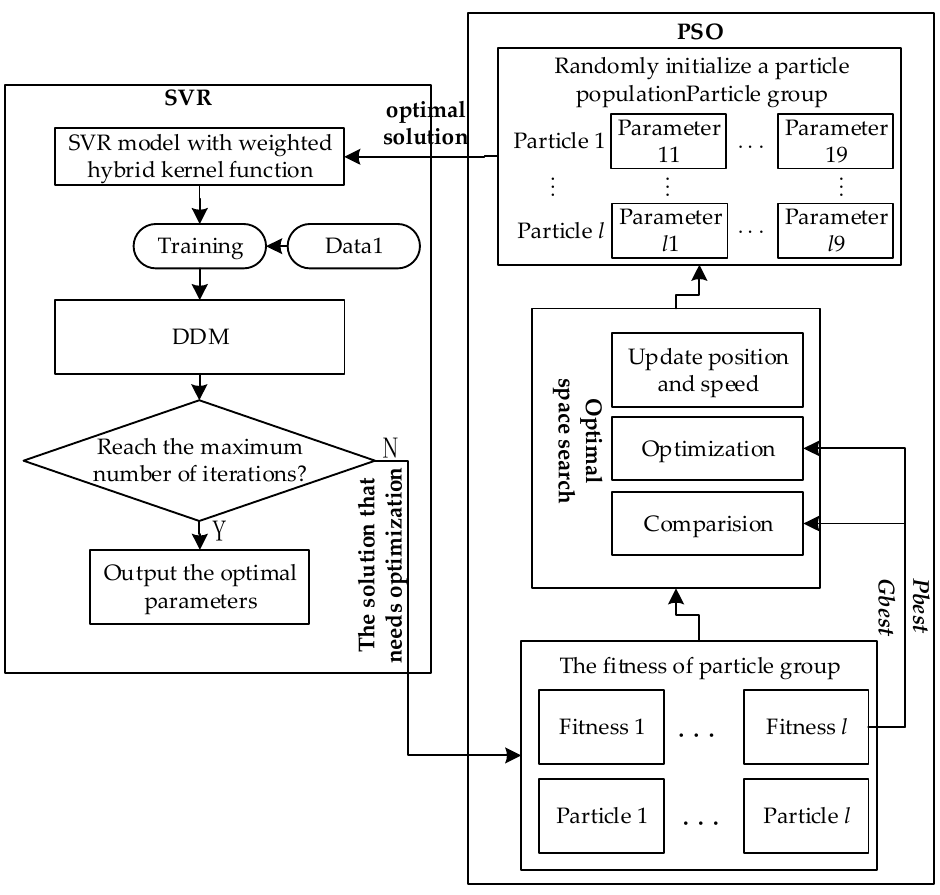
Figure 4. The steps of Particle Swarm Optimization (PSO)—Support Vector Machine Regression (SVR) parameters optimization architecture.